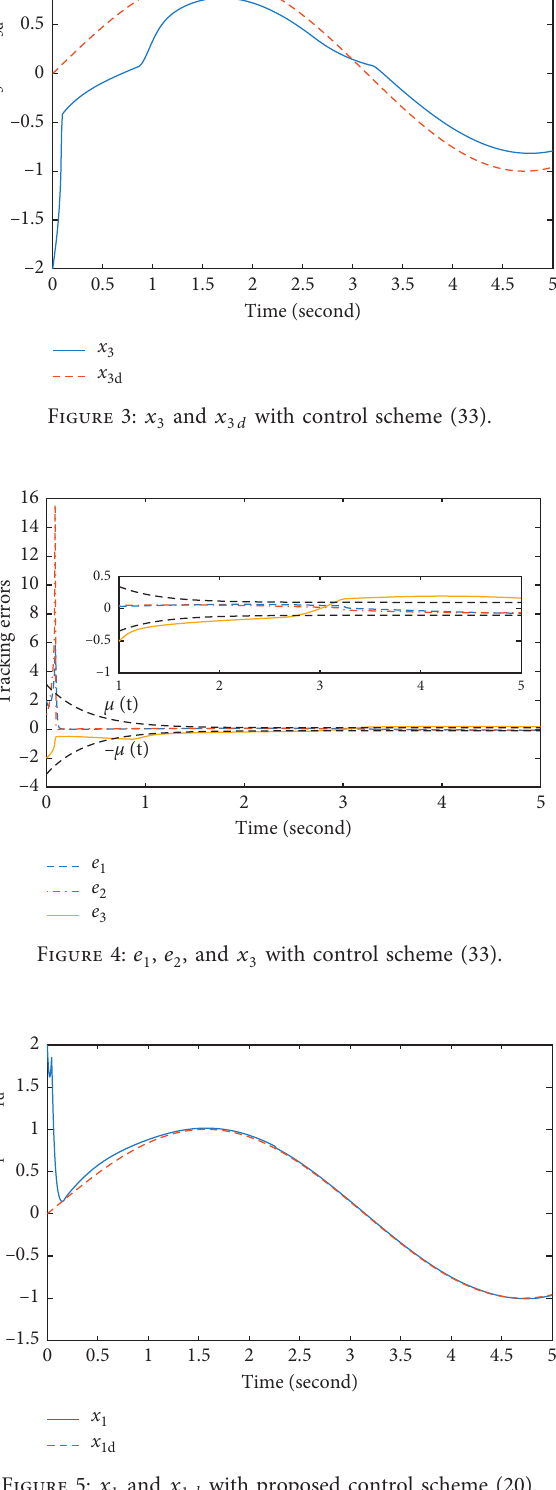
and x with proposed control scheme (20). 1 1 d